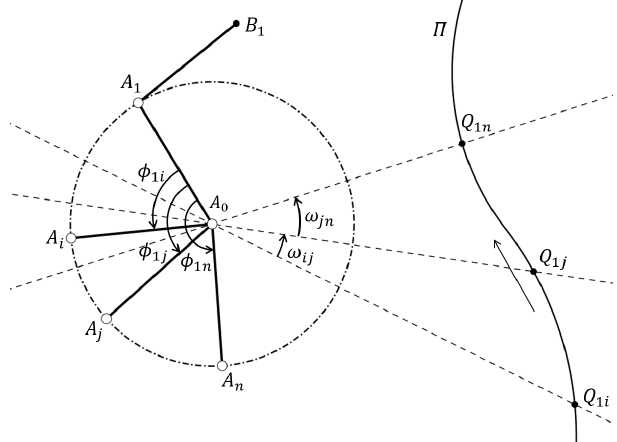
Figure 19. Relationship between input angle and pole